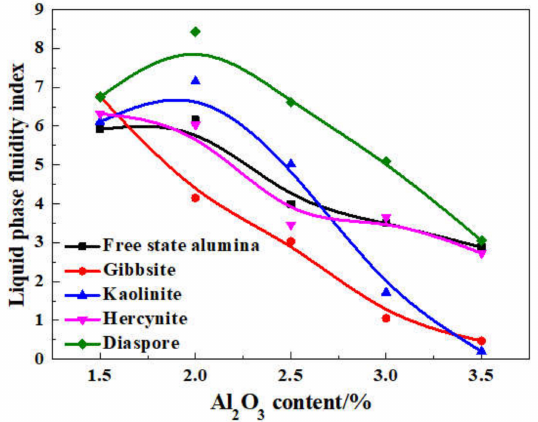
Figure 9. Influence of alumina concentration and type on liquid phase